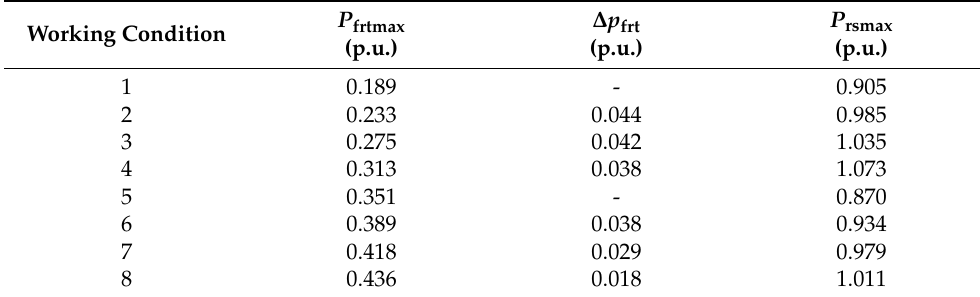
Table 4. Active power index in cases (1)–(8) of the fault on location A. Working